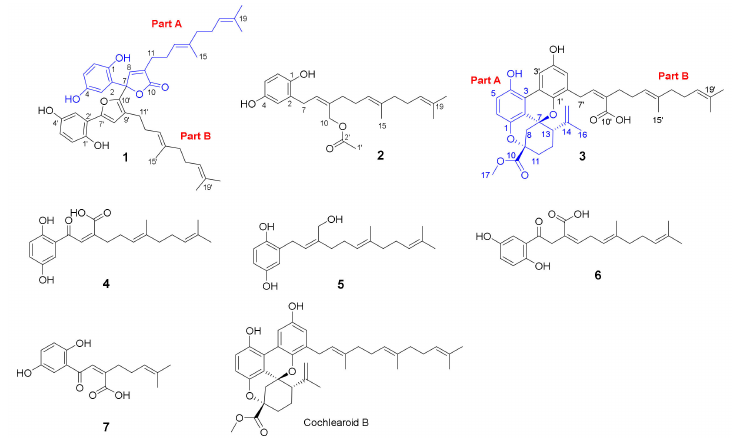
Figure 1. The structures of compounds 1 – 7 from Ganoderma cochlear